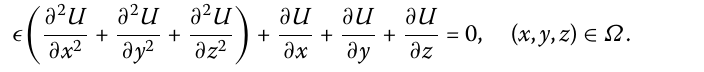
Table 1g and Table 1h for b = c = d = 1 and b = x + y , c = y + z , d = x + z , respectively. Example 5.2 Consider the linear convection-diffusion